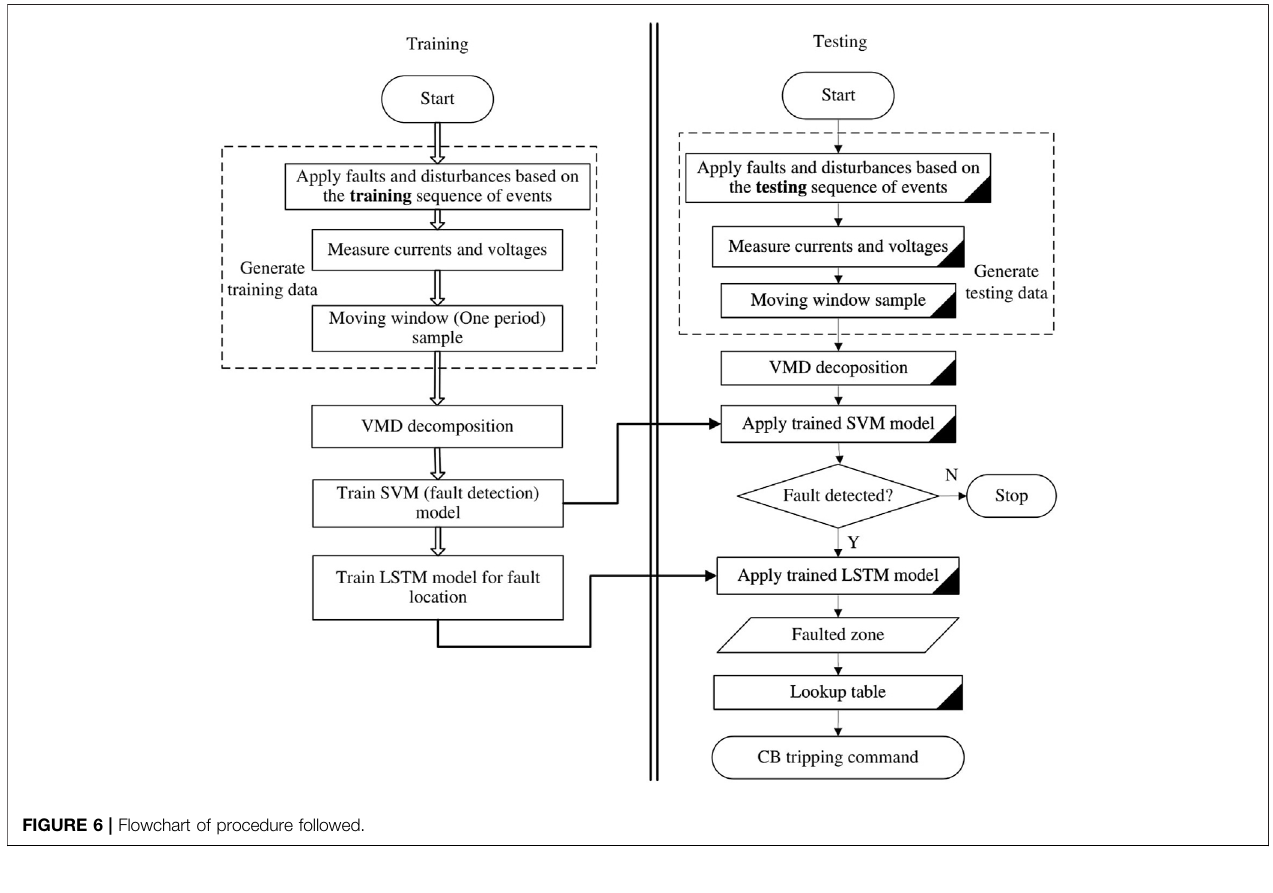
FIGURE 6 | Flowchart of procedure followed.